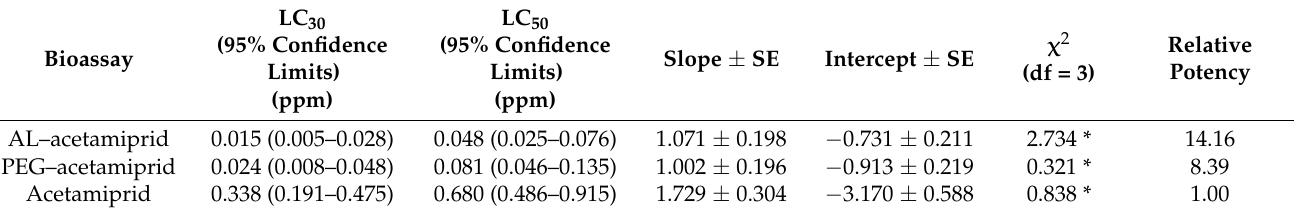
Table 1. Probit analysis of free and nanoencapsulated acetamiprid based on AL and PEG on third- instar larvae of Xanthogaleruca luteola .